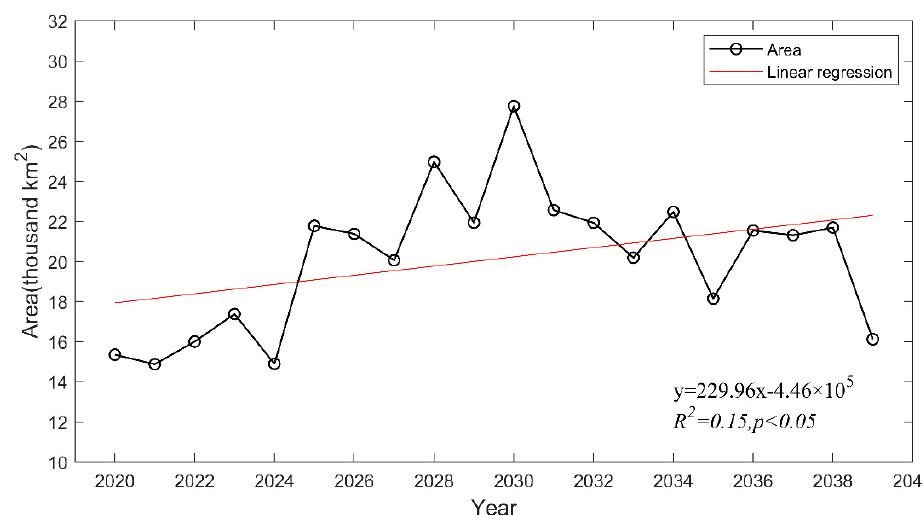
Figure 3. Annual extreme precipitation events areal coverage on the Loess Plateau for the 1.5 °C global warming scenario.